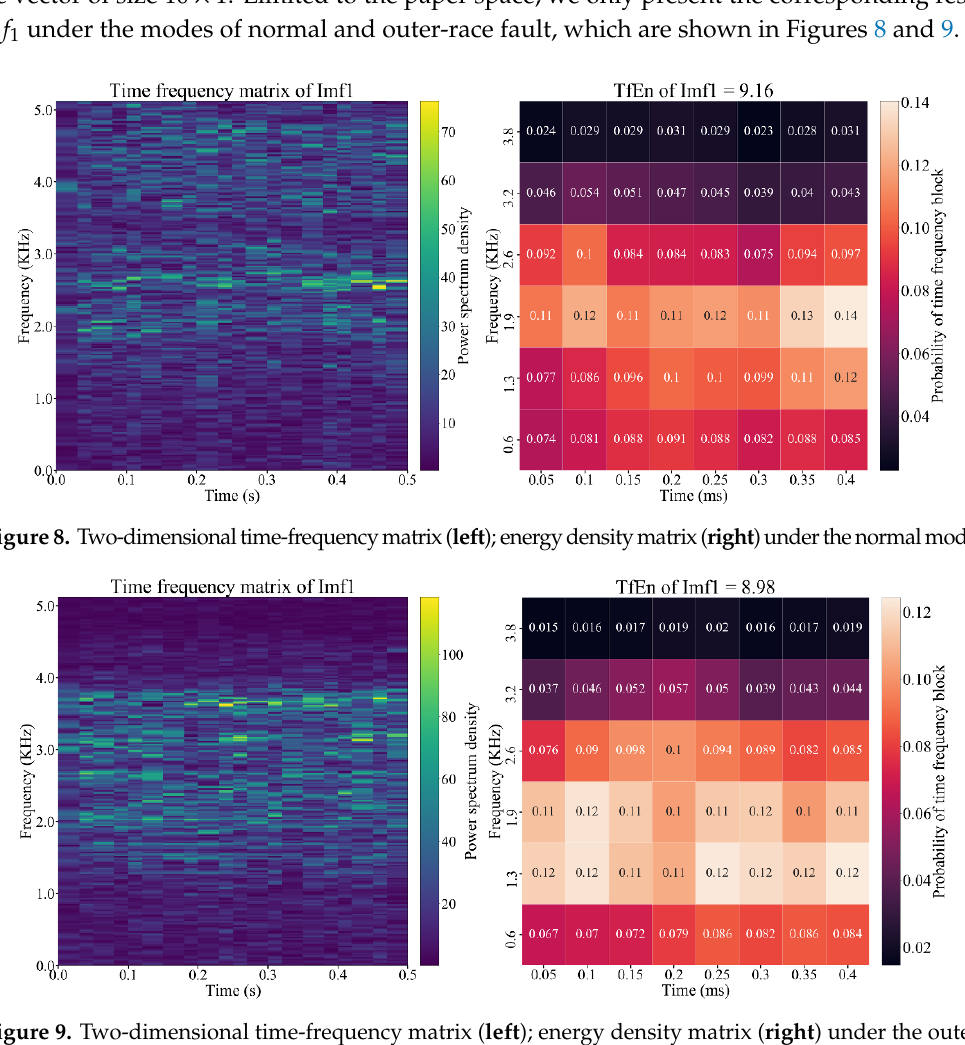
Figure 9. Two-dimensional time-frequency matrix ( left ); energy density matrix ( right ) under the outer-race fault.